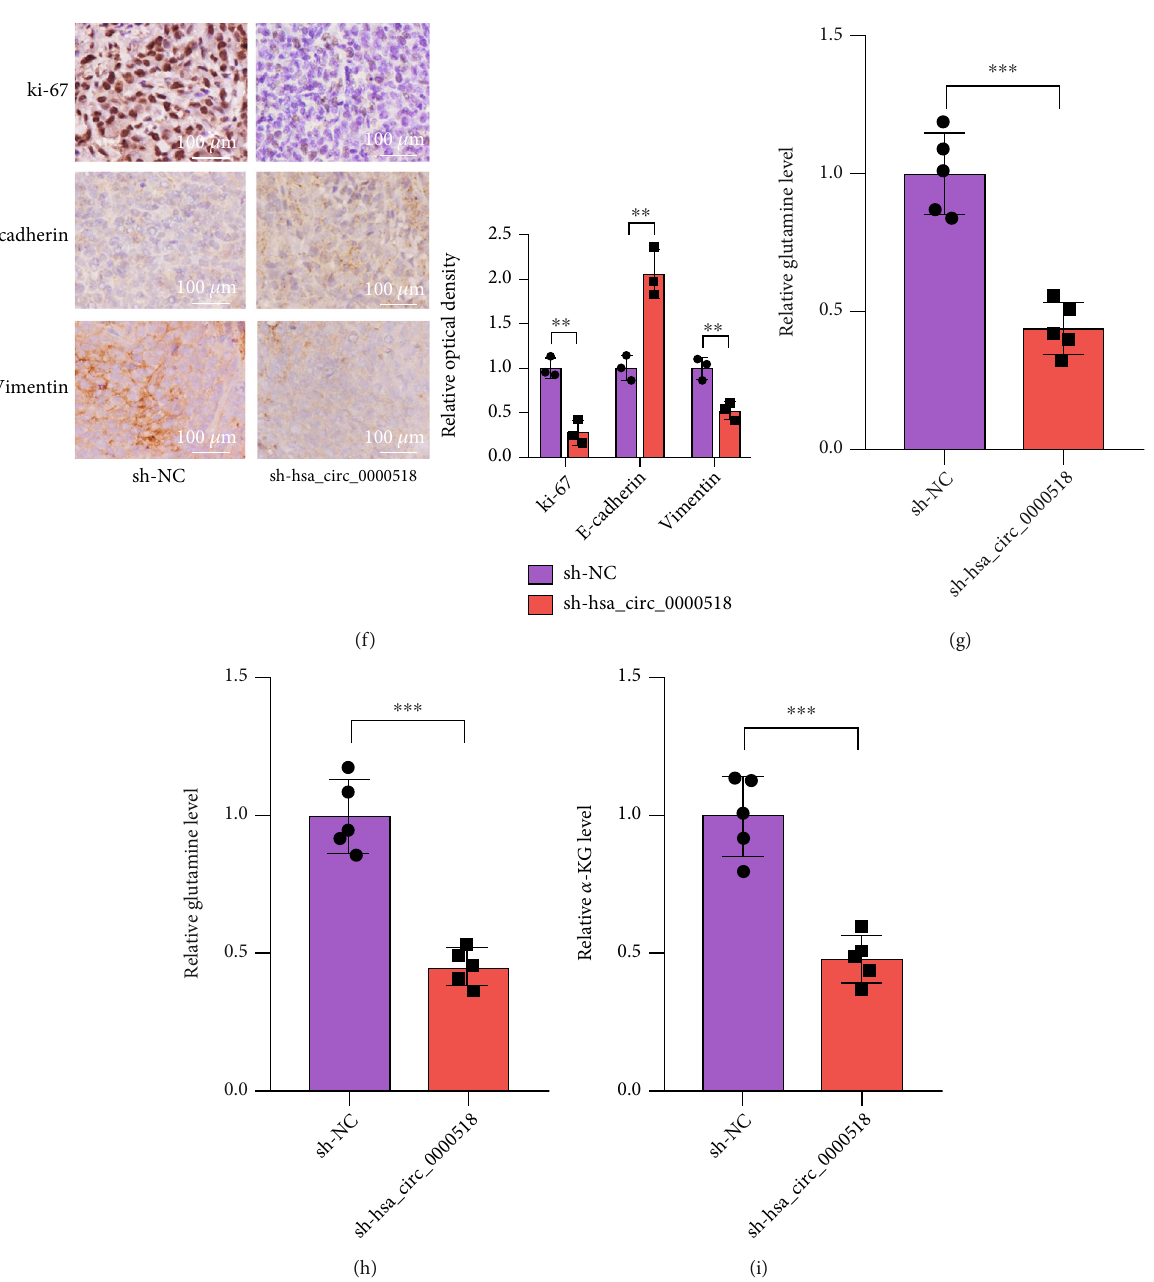
Figure 6: sh-circ_0000518 restrains tumor development. (a) The nude mice ’ s weight from each group did not change signi fi cantly during the experiment. (b) Tumor weights were plotted and showed that circ_0000518 silencing has lower tumor weights. (c) Tumor volume curve was analyzed. (d, e) circ_0000518, miR-330-3p, and SLC1A5 levels within xenograft tumors by qRT-PCR and western blot assays. (f) Immunohistochemistry staining for Ki-67, E-cadherin, and vimentin of the tumor sections in both the groups ( × 400). (g – i) Levels of glutamine, glutamate, and α -KG in the sh-circ_0000518 groups and sh-NC groups were measured by ELISA. The photographs are representative. ∗ p < 0 : 05 , ∗∗ p < 0 : 01 , ∗∗∗ p < 0 : 001